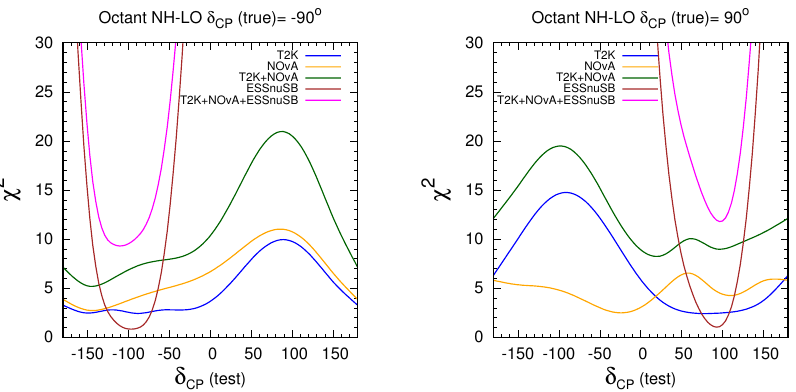
Figure 7 . Octant sensitivity vs. (cid:14) CP (test) for ESS (cid:23) SB , T2K and NO (cid:23) A with (cid:14) CP (true) = (cid:6) 90 (cid:14) . The true hierarchy and true octant are taken as NH and LO respectively. Left panel